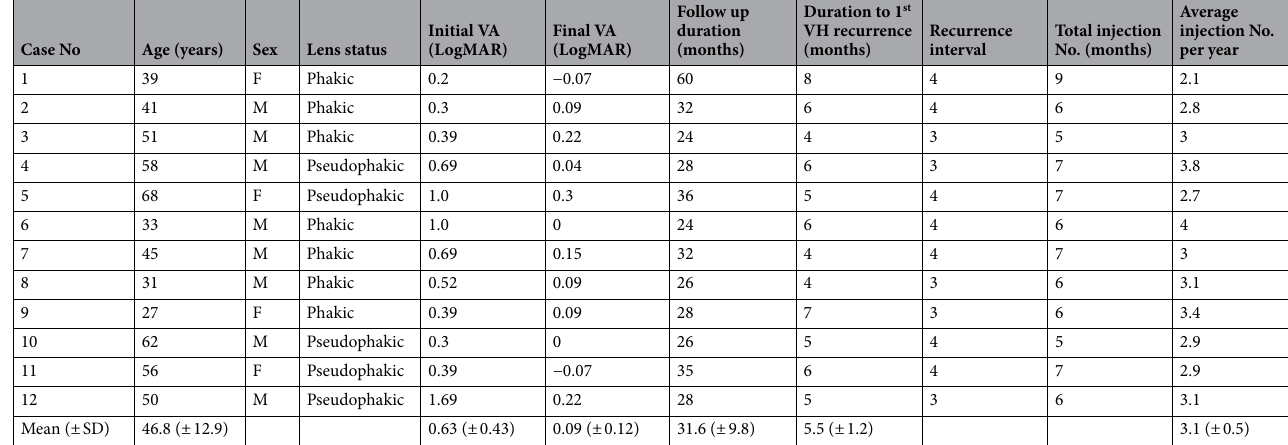
Table 1. The characteristics of the patients. No. number, LogMAR Logarithm of the Minimum Angle of Resolution, VH vitreous hemorrhage, F female, M male, SD standard